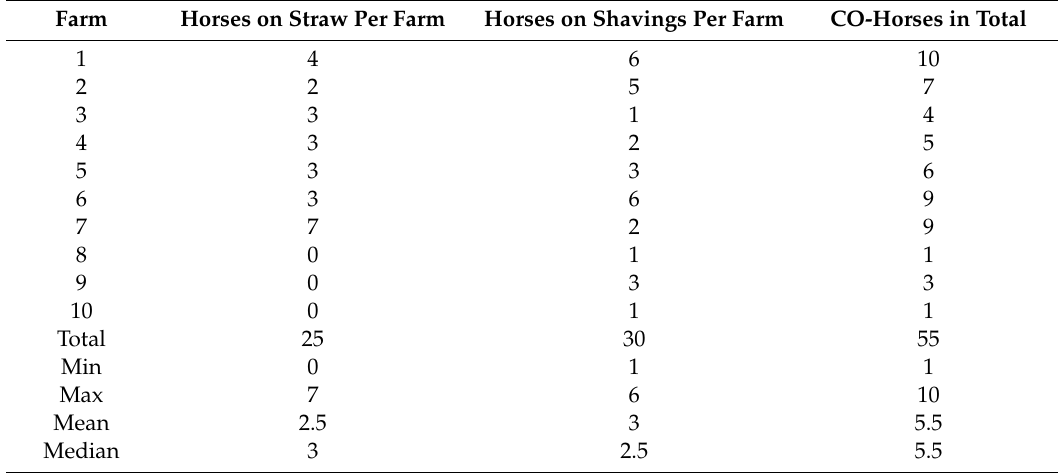
Table 2. Number of Continuously Observed (CO-) horses per farm and condition (bedding material: straw and